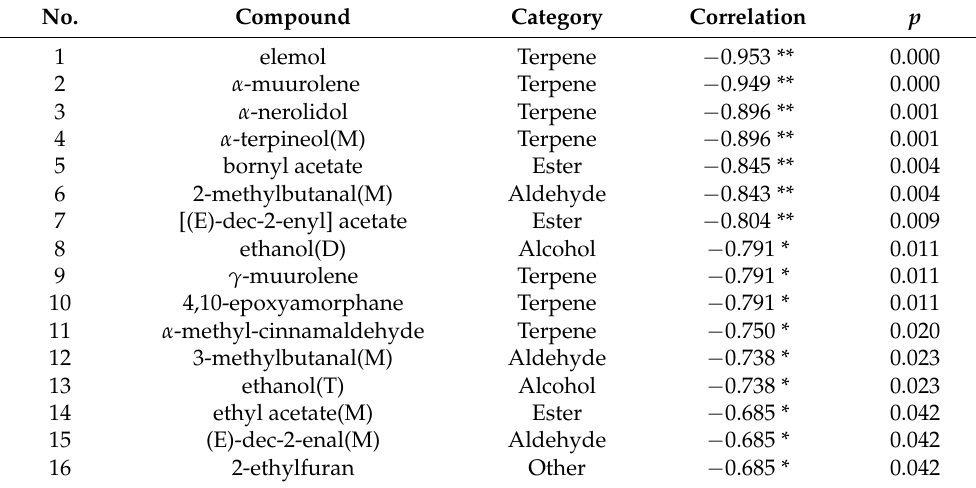
Table 2. Spearman’s correlation between the compounds’ contents (Tables S1 and S2) from AEOs from different regions and the minimum inhibitory concentration (MIC) of Staphylococcus aureus ( S. aureus). No.